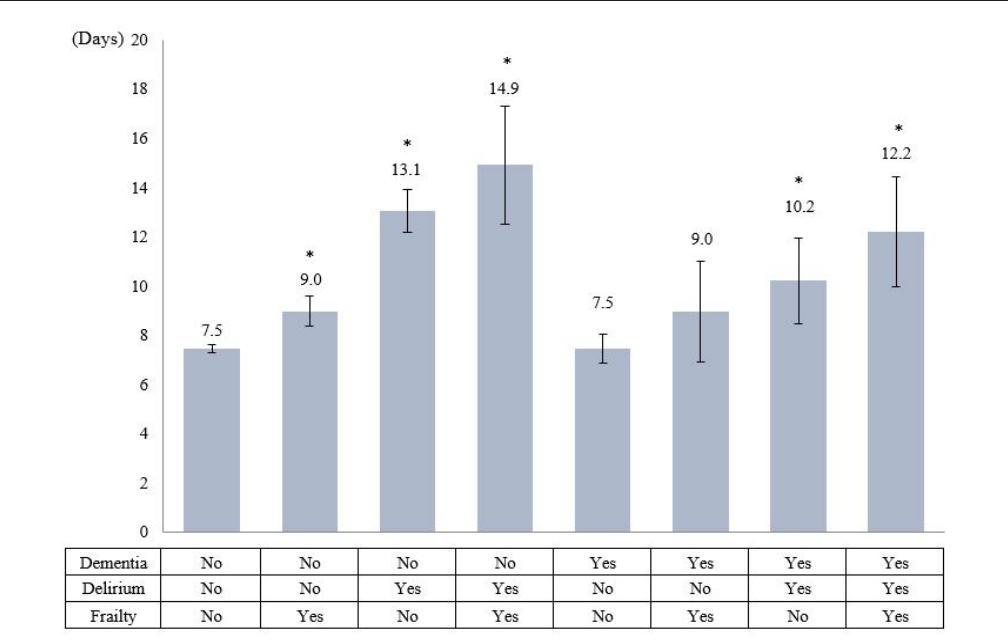
Figure 3. Predicted Average LOS for Each Condition from the Final Regression Model with Interaction Terms